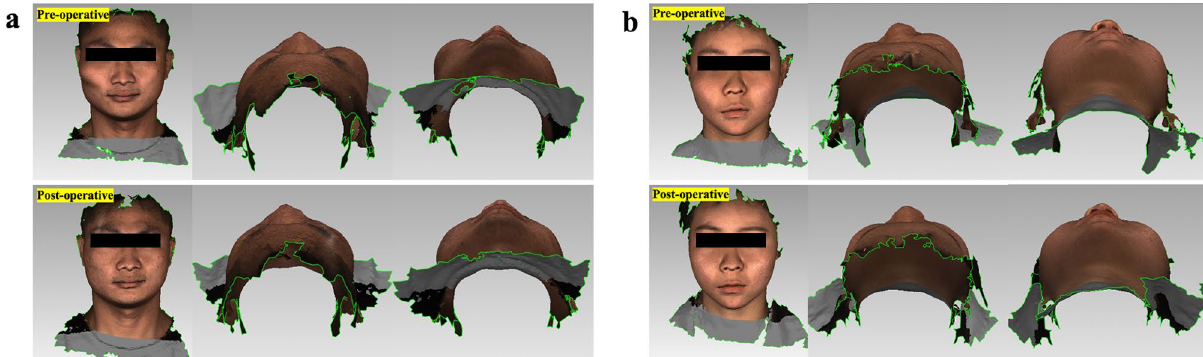
Figure 6. Case presentation: ( a ) A patient (male, 29 years old) with fibrous dysplasia in the right zygomaticomaxillary region. ( b ) A patient (female, 18 years old) with fibrous dysplasia in the right zygomaticomaxillary